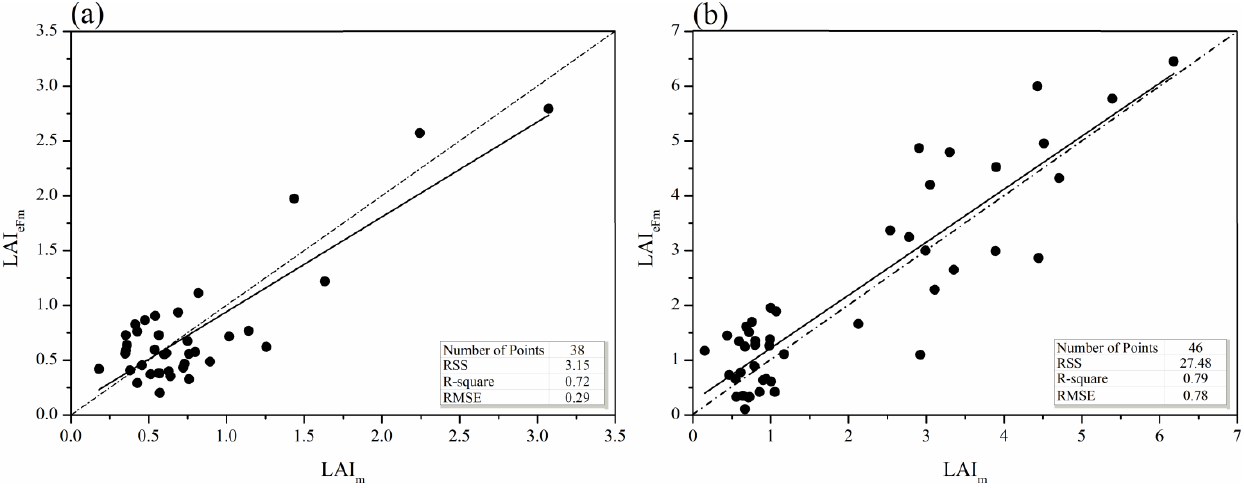
Figure 10. Results of the LAIe F values compared to the LAI m values in early July ( a ) and late August ( b )